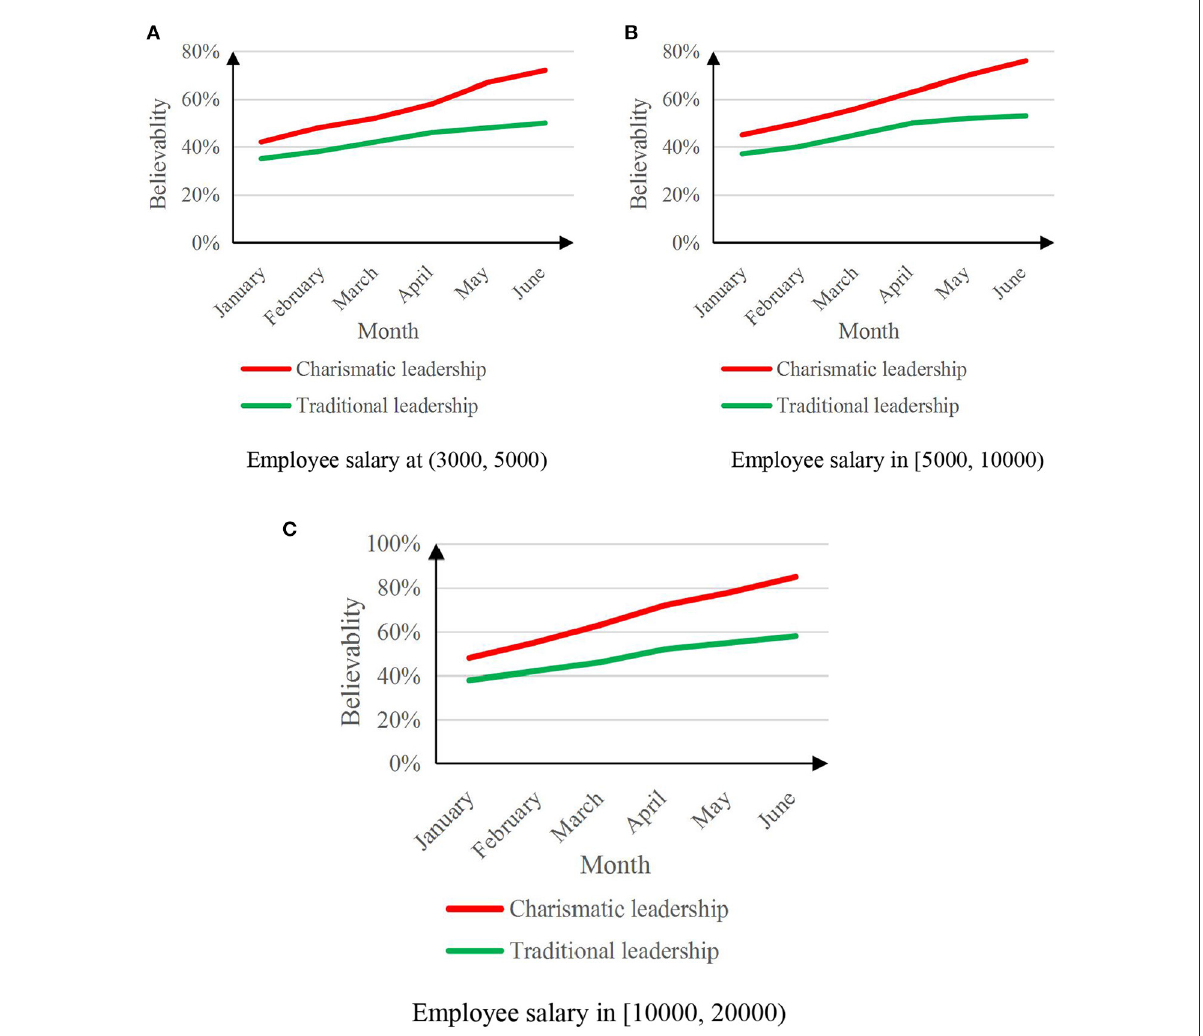
FIGURE7 Graph of employee trust in two types of leaders. (A) Employee salary at (3,000, 5,000). (B) Employee salary in [5,000, 10,000). (C) Employee salary in [10,000, 20,000].